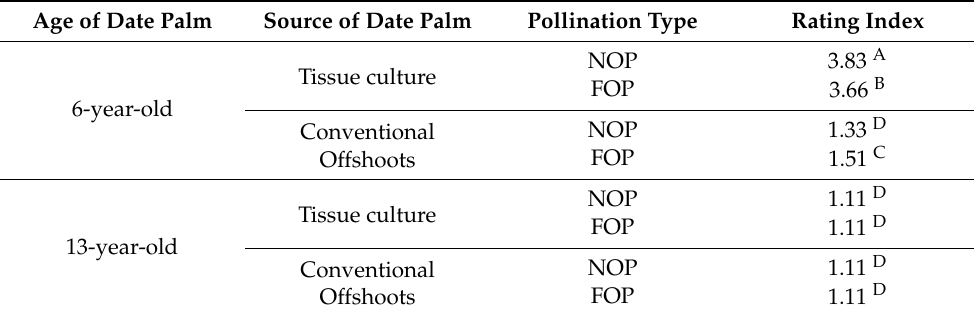
Table 3. Rate of abnormal fruit setting in tissue culture and offshoot-derived date palms of cv.